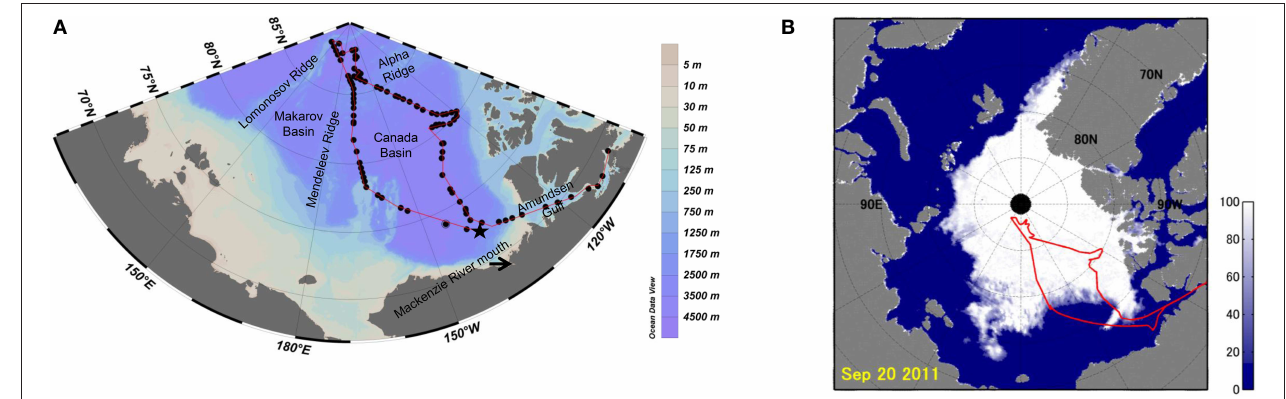
FIGURE 1 | (A) Transect occupied by the CCGS Louis S.St-Laurent ( − ) and discrete sampling locations ( • ). The start of the section shown in Figure 2B is represented by a star. (B) Arctic ice concentrations from Advanced Microwave Scanning Radiometer—Earth Observing System (AMSR-E) for the September 20th, 2011.